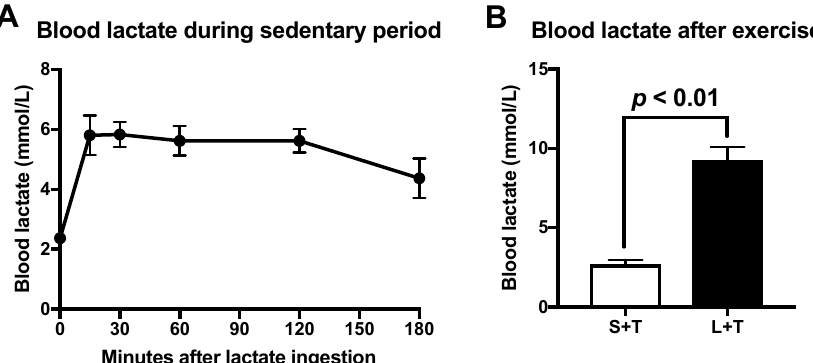
Figure 1. Blood lactate concentration following lactate ingestion during sedentary period ( A ). Blood lactate concentration immediately after the exercise ( B ). Data are presented as means ± SEM ( n = 8).